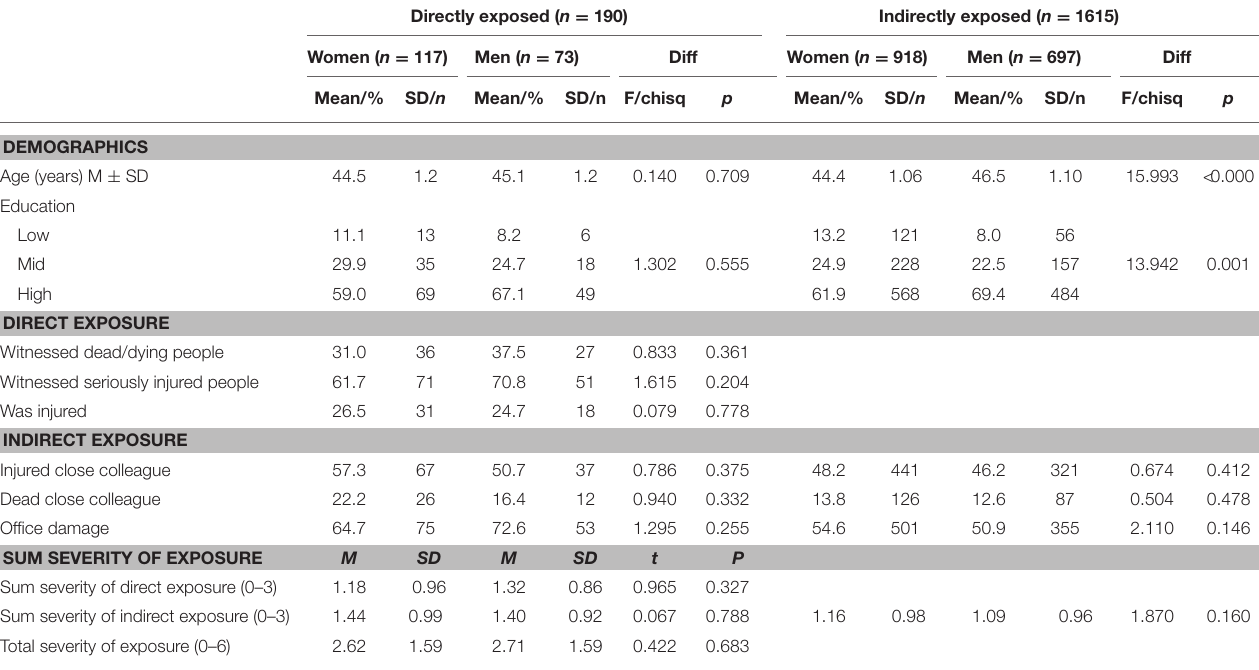
TABLE 1 | Characteristics of the sample.